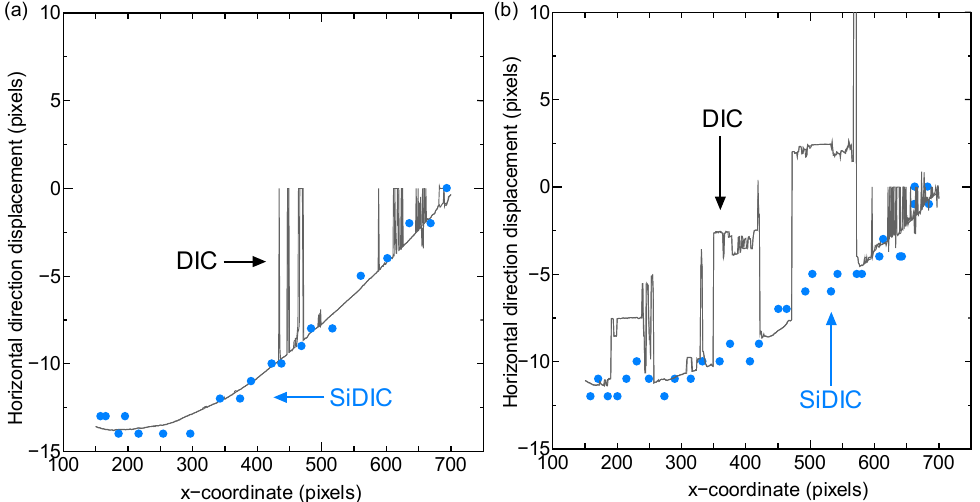
Figure 9. Comparison of horizontal displacement distributions obtained by DIC and SiDIC for the control paths highlighted in Figure 8: ( a ) Central dotted line; ( b ) Upper dotted line.